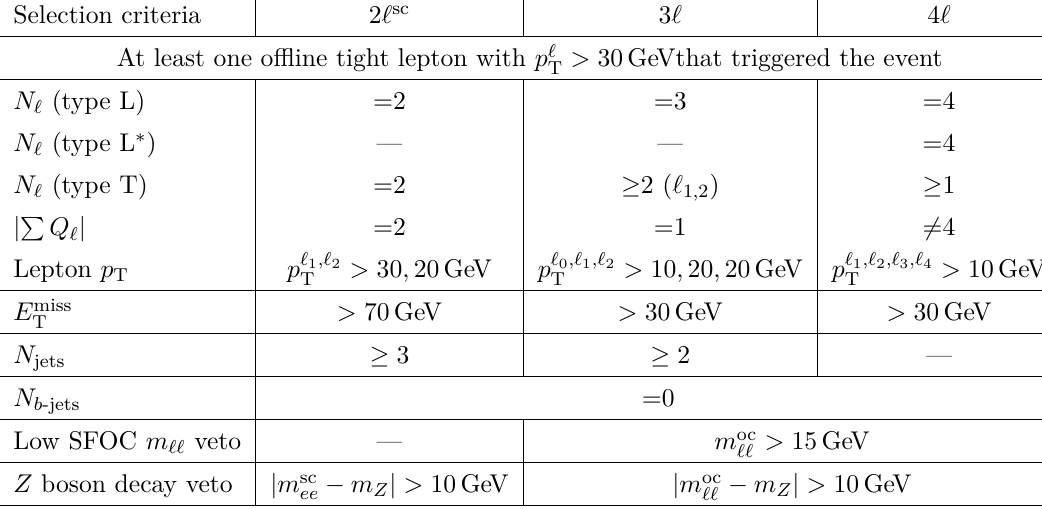
Table 4 . The preselection criteria for the 2 ‘ sc , 3 ‘ and 4 ‘ analysis channels. The leptons are required to pass the loose (L), loose and minimally isolated (L ∗ ) or tight (T) requirements. The leptons are ordered by decreasing p ( ‘ ) in the 2 ‘ sc and 4 ‘ channels, while for the 3 ‘ channel ‘ T 1 , ‘ 2 , . . . denote the two same-charge leptons and ‘ denotes the lepton with a charge opposite to the total 0 lepton charge. Q denotes the charge of each lepton. SFOC refers to same-flavour opposite-charge ‘ lepton pairs. The symbol “—” means no requirement is made. The equal sign (=) is used to emphasise that the selection criterion has to be exactly the given